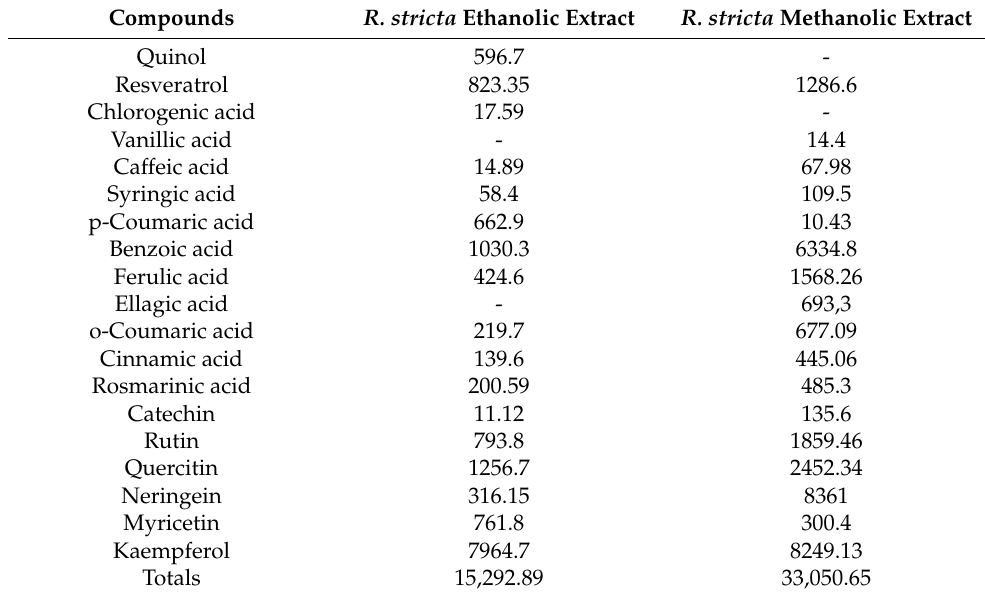
Table 5. Chemical compositions of R. stricta extracts